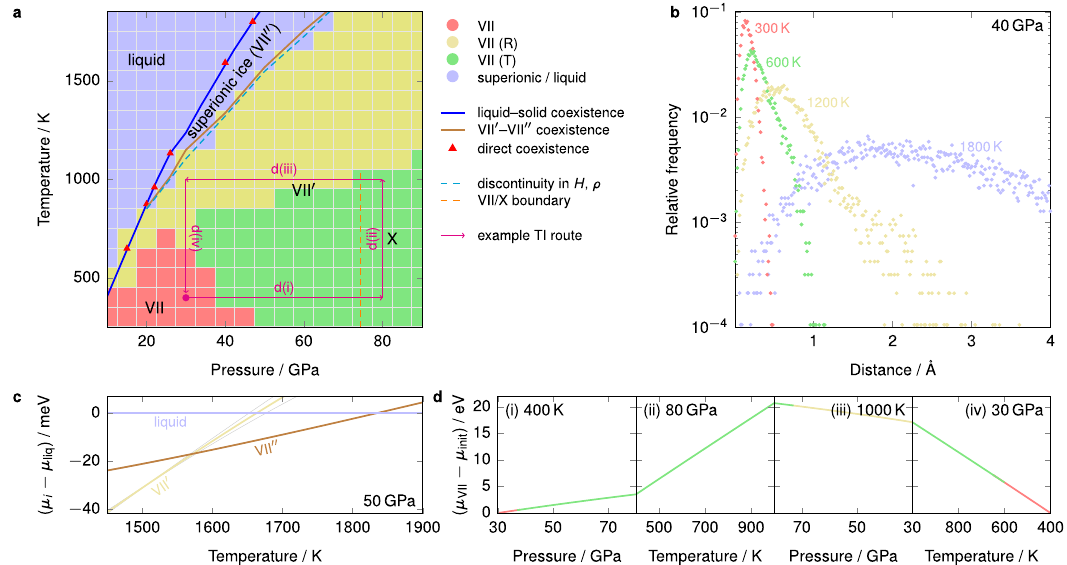
Fig. 1 | Low-pressure bcc phase behaviour. a Low-pressure phase diagram. The background colour corresponds to the classi fi cation shown in panel b . Blue and brown solid coexistence lines were computed from chemical-potential differences usingthermodynamicintegration(TI).Severalpointswerebenchmarkedbydirect- coexistencesimulations atthe points indicated.The dashed cyanline corresponds to points where the enthalpy and density are discontinuous along isobars (see Supplementary Fig. 1). The dashed orange line corresponds to the approximate point where the fi rst secondary maximum in the O – H pair correlation function disappears. The thin magenta line gives anexample TIroute discussed in the main text (see panel d ). b Mean frequency of proton displacement after 0.4ps for MD simulations started from bcc ice at 40GPa. Red corresponds to a symmetric unimodal distribution at small displacement ( ‘ static ice ’ ). Green corresponds to